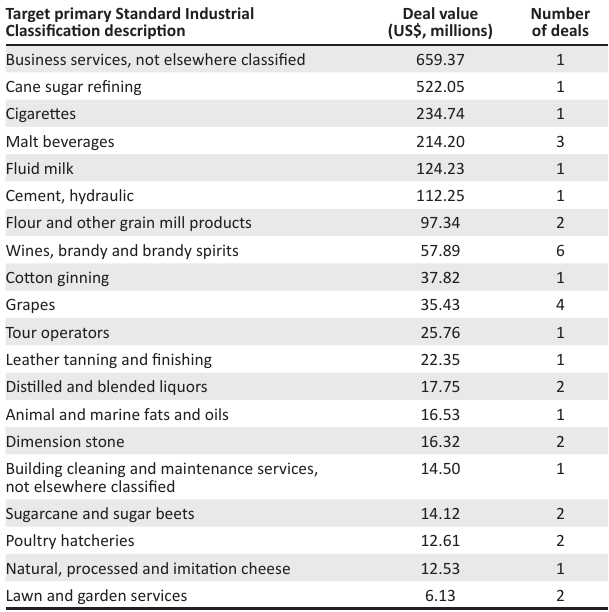
TABLE 8: Agricultural mergers and acquisitions inflows into South Africa by industry activity, 2003–2014.